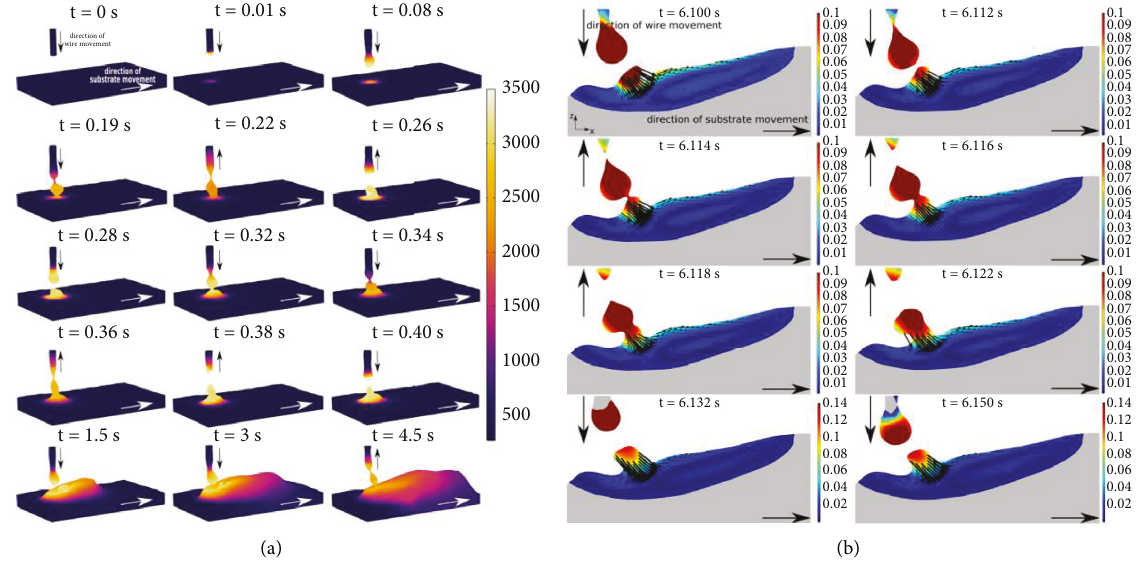
Figure 11: (a) Sequence of temperature fields (in (K)) during the detachment of the first two droplets (from t � 0 to 0.4 (s)) and the growth of the melt pool during the build-up of the wall (from t � 1.5 to 4.5 (s)). The black arrow indicates the direction of the wire, and the white one indicates the relative motion of the substrate. (b) Longitudinal cross-sectional view ( xz plane) of the fluid velocity field during metal transfer.